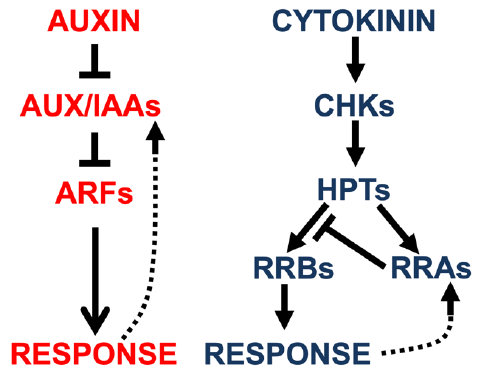
Figure 1. Simplified schemes of the auxin and cytokinin response pathways. Abbreviations: AUX/IAAs, auxin/indole-3-acetic acid regulators; ARFs, auxin response factors; CHKs, cytokinin histidine kinase receptors; HPTs, histidine phosphotransfer proteins; RRBs, type-B response regulators; RRAs, type-A response regulators.